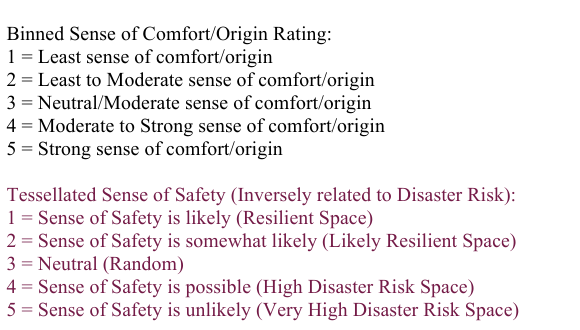
Table 1 shows the practical implications of Topophilia-Exposure: prevention and recovery are interrelated to issues on